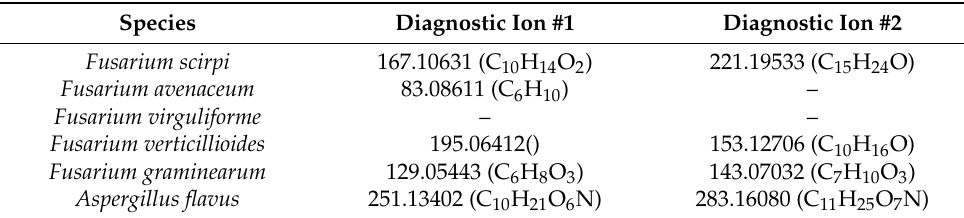
Figure 4. Intensities of selected ions from week 2 of sampling from cultures of ( A ) F. scirpi , ( B ) F. avenaceum , ( C ) F. virguliforme , ( D ) F. verticillioides , and ( E ) F. graminearum . Intensities are normalized relative to the diagnostic ion for cracked maize ( m/z 86). Intensities shown are averages of measurements conducted, and error bars indicate calculated standard deviations for the six measurements. Table 2. Diagnostic ions selected for fungal species. Empirical formulae for diagnostic ions are based upon most probable elemental composition calculated for the high-resolution masses with Thermo Compound Discover.